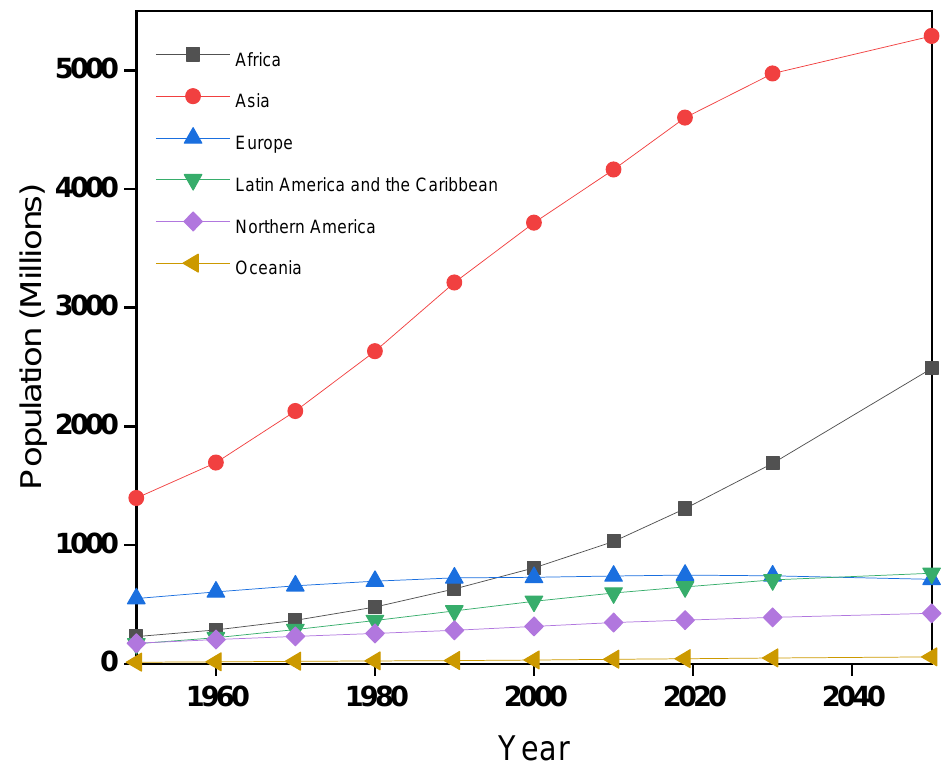
Figure 2. World population, both sexes combined (Million) [17].